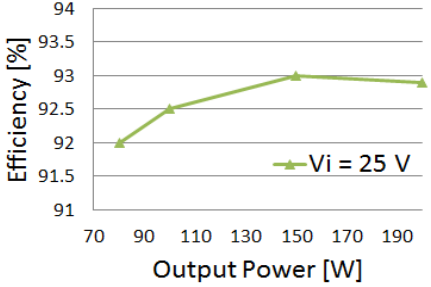
Figure 12. Converter efficiency with different output powers.